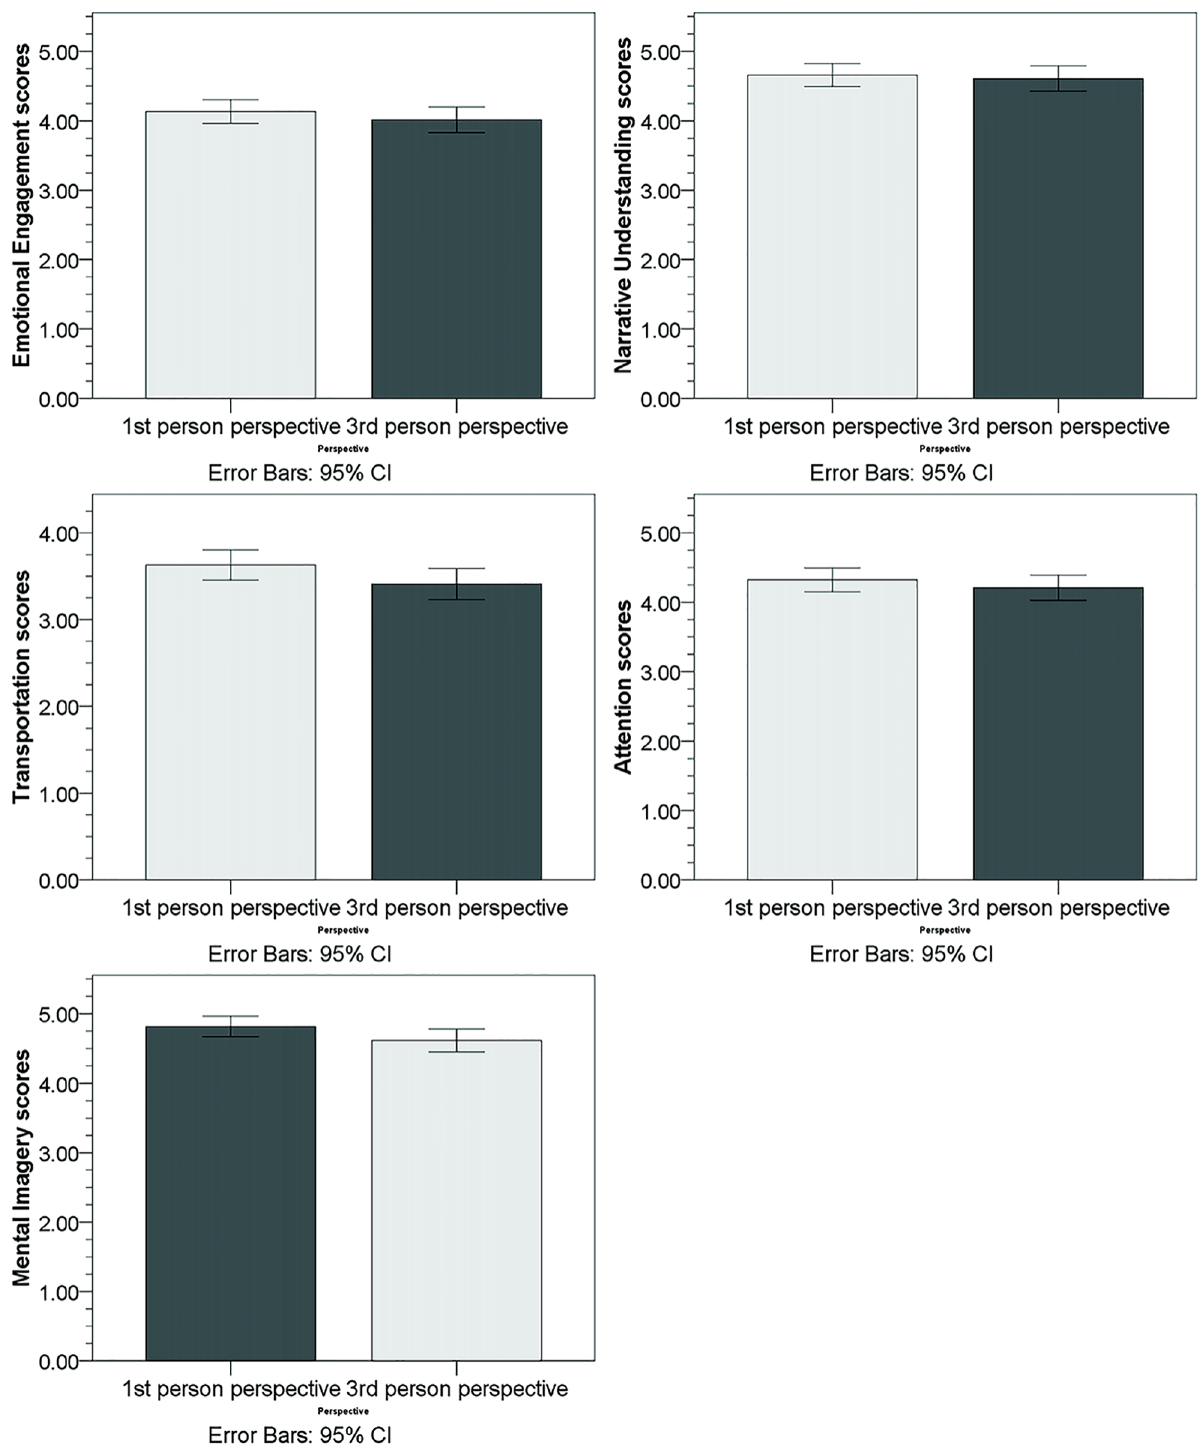
Fig 2. Subscales of the immersion questionnaire. The subscales were emotional engagement, narrative understanding, transportation, attention, and mental imagery. Differences between stories with 1st and 3rd person pronouns referring to the protagonist were significant for the transportation and the mental imagery